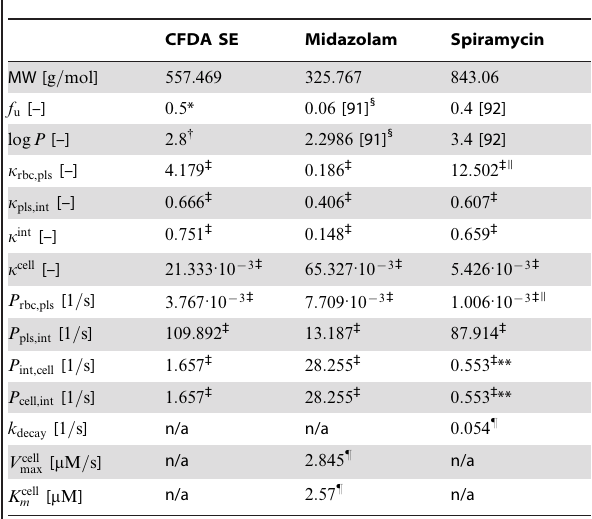
Table 1. PBPK parameters for the compounds considered.